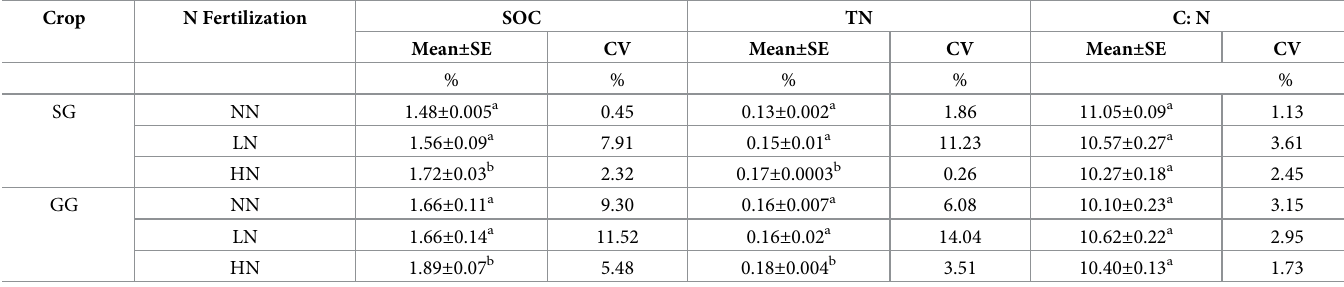
Table 2. Mean ( ± SE) SOC and TN concentrations (%), and C: N as well as their respective coefficients of variance (CV, %) under three fertilization treatments in SG and GG croplands at the fertilization experiment in TSU AERC in Nashville, TN, USA. Crop N